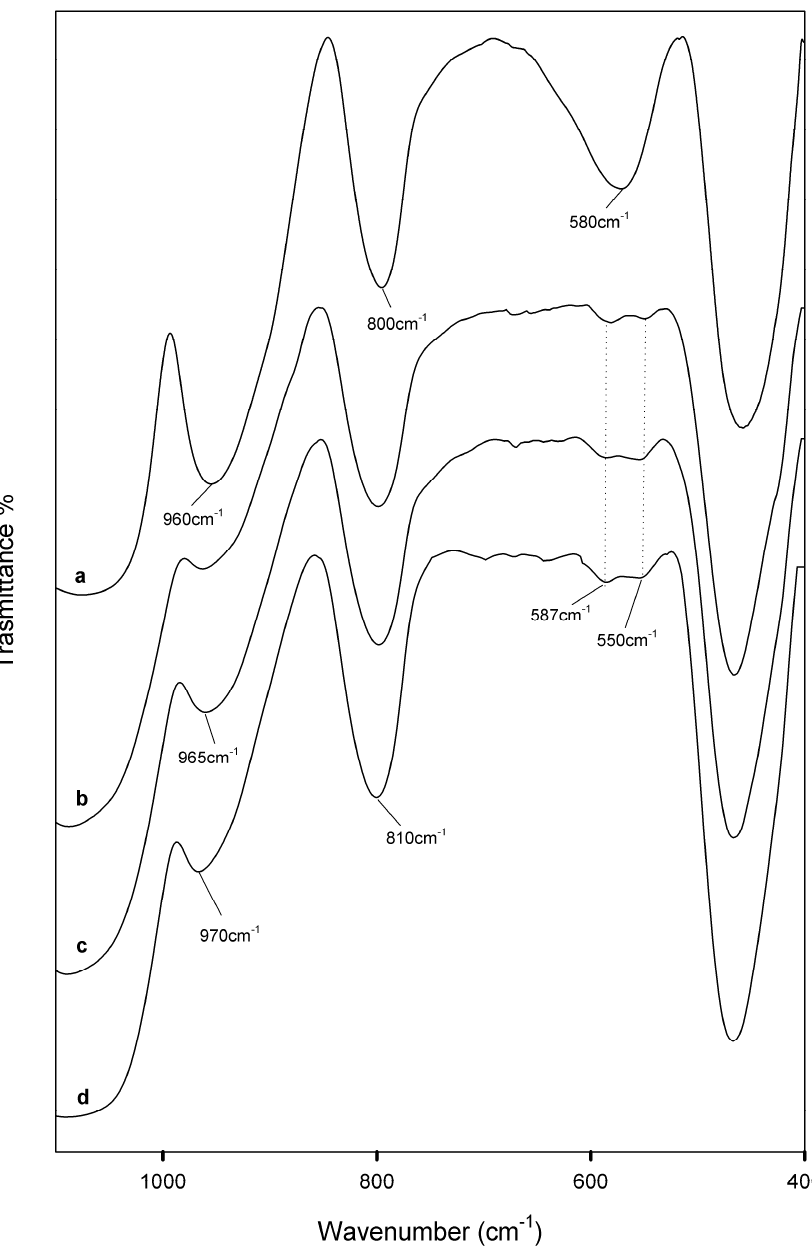
Figure 7. FT-IR spectra of SiO 2 /PCL gel samples after exposure to simulated body fluid (SBF) for different times. ( a ) not exposed; ( b ) 7 days; ( c ) 14 days; ( d ) 21 days.